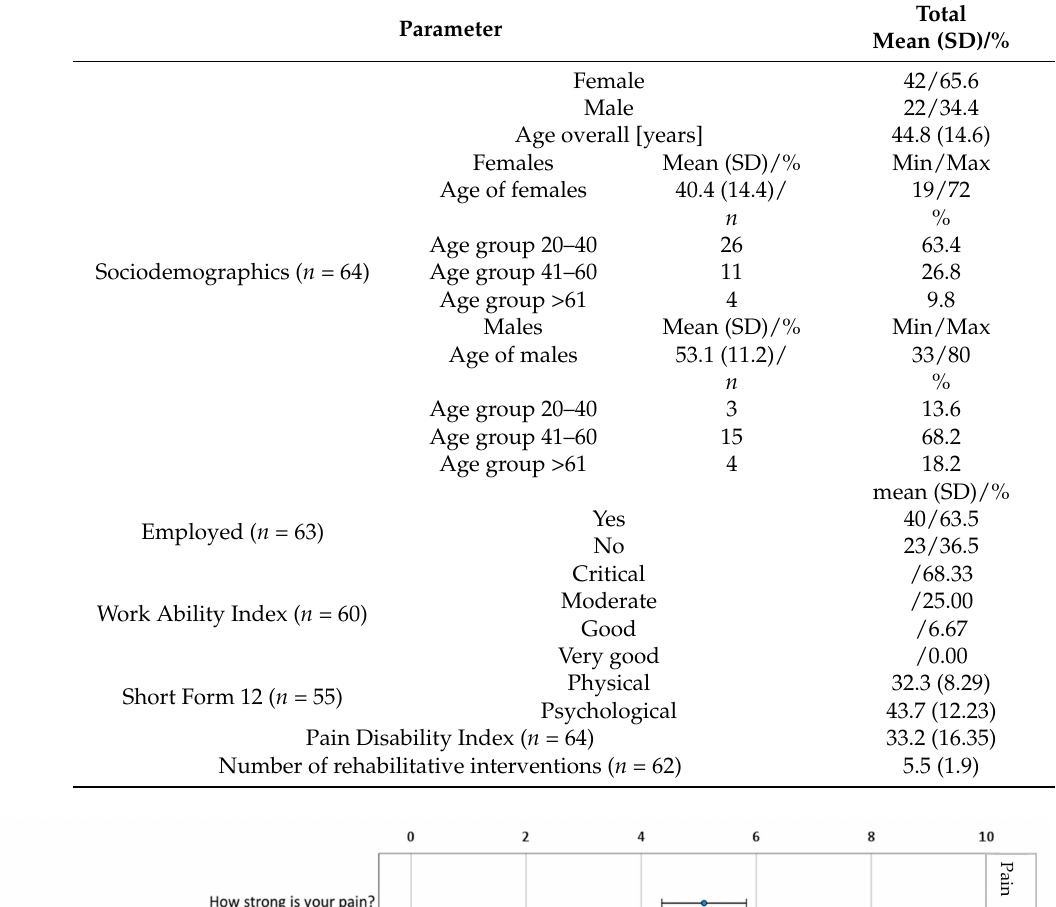
Table 1. Several parameters of the cohort including sociodemographic characteristics and data from WAI, SF-12, PDI, and rehabilitative interventions.